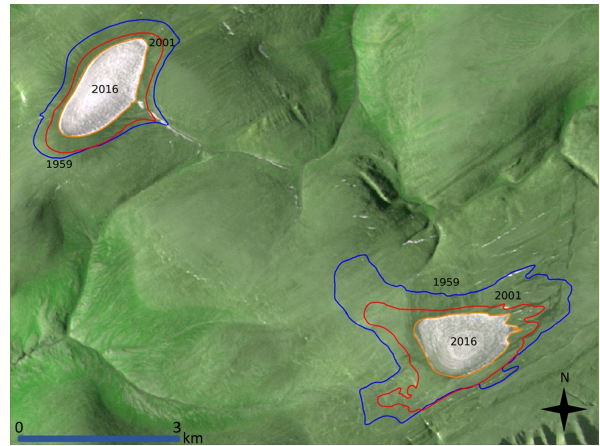
Figure 2. Outlines of the St. Patrick Bay ice caps based on aerial photography from August 1959, GPS surveys conducted during Au- gust 2001, and for August of 2014 and 2015 from ASTER. The base image is from August 2015.